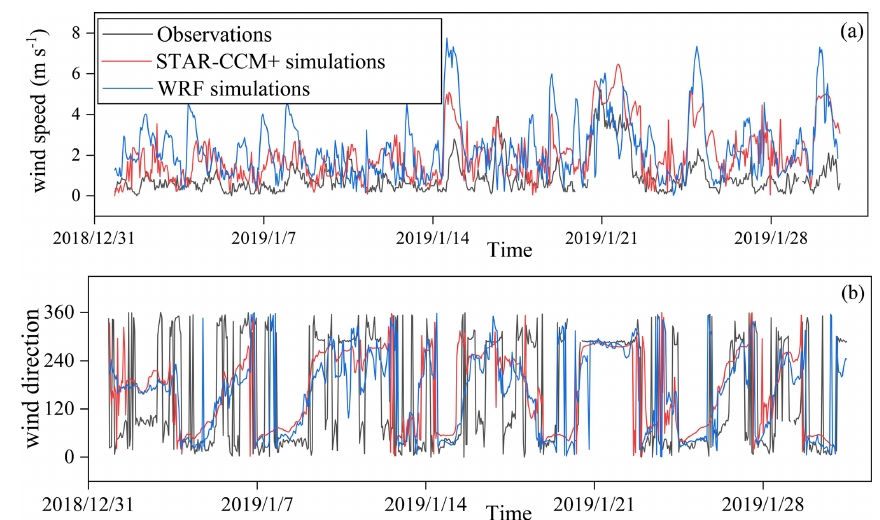
Figure 4. Evaluation of the wind simulation results at the BSC monitoring site (see in Fig. 3a): the simulated (by the WRF (blue line) and STAR-CCM+ (red line) models) and the observed (grey line) hourly near-surface wind speeds (a) and wind directions (b) .